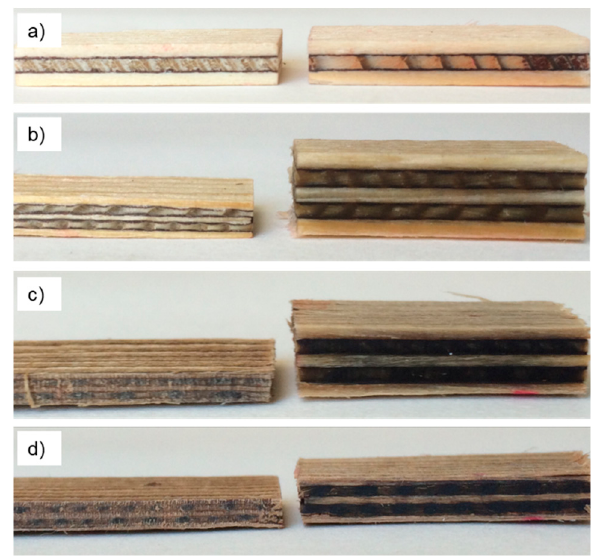
Figure 7. Representative photographs showing the swelling behavior of plywood samples: ( a ) made of reference veneers; ( b ) made of densified water-soaked veneers; ( c ) made of densified alkali-treated veneers; ( d ) made of densified organosolv-treated veneers. (Conditions: left = 20 °C, 65% relative humidity; right = after complete immersion in 20 °C deionized water for 24 h).